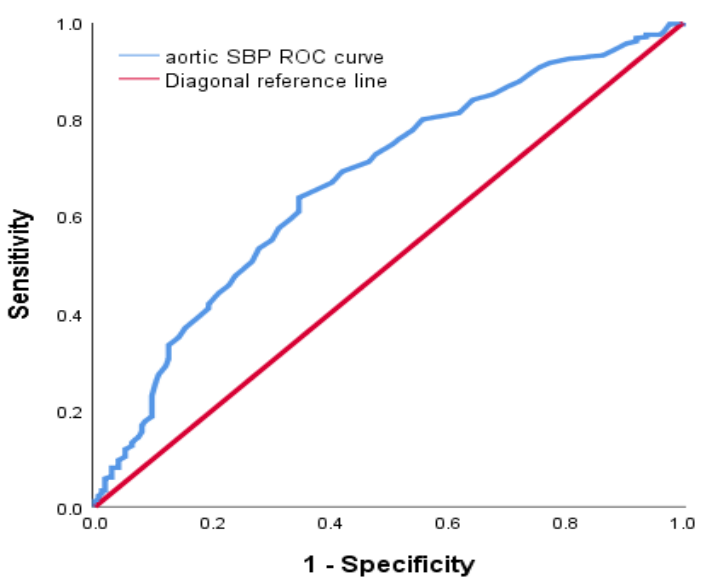
Figure 5. Receiver operating characteristic (ROC) curve to determine the cut-off value of aortic systolic blood pressure for risk of ASCVD. The cut-off point of 124.5 mmHg showed a sensitivity of 63.9%, a specificity of 65.3%, and an area under the curve (AUC) of